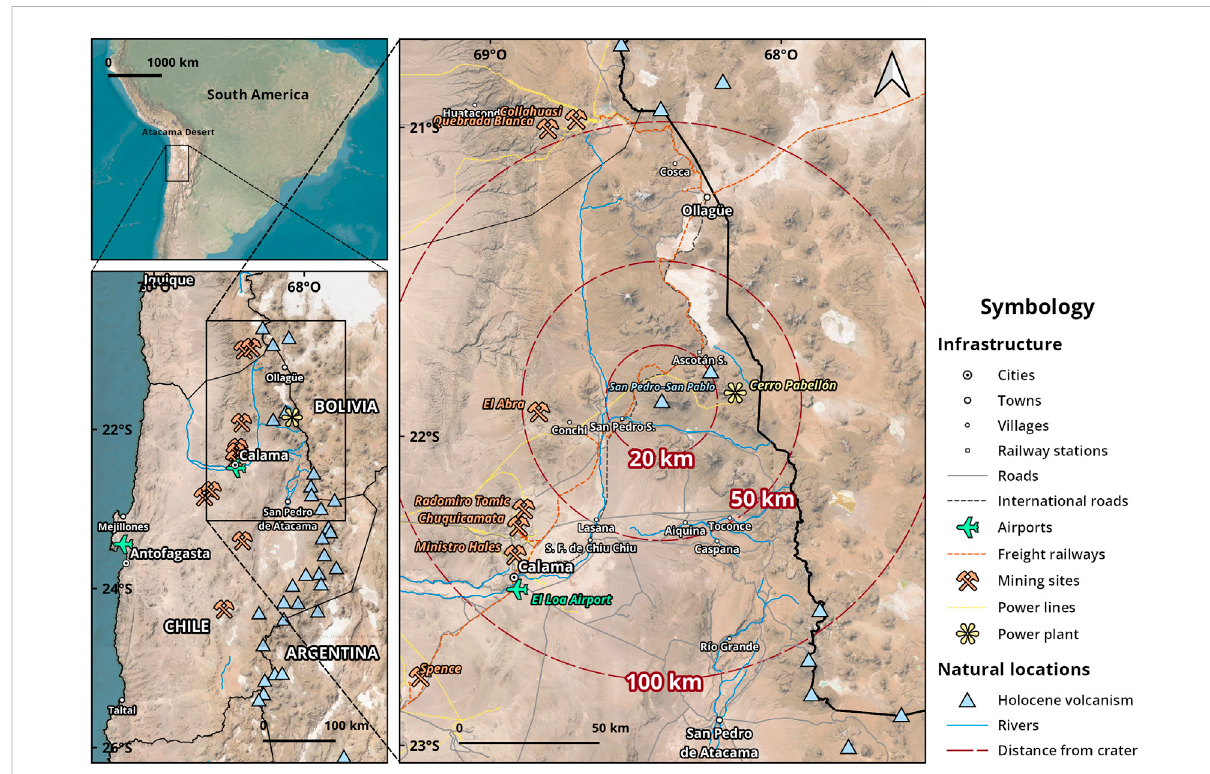
FIGURE 1 Ubication map showing locations and infrastructures at different radial distances from the San Pedro volcano. ‘ World imagery ’ and ‘ Terrain hillshade ’ base maps courtesy of ESRI and others. Volcanic data from Global Volcanism Program database, version 4.10.4 (GVP, 2013c). Additional cartography data was obtained from the OpenStreetMap